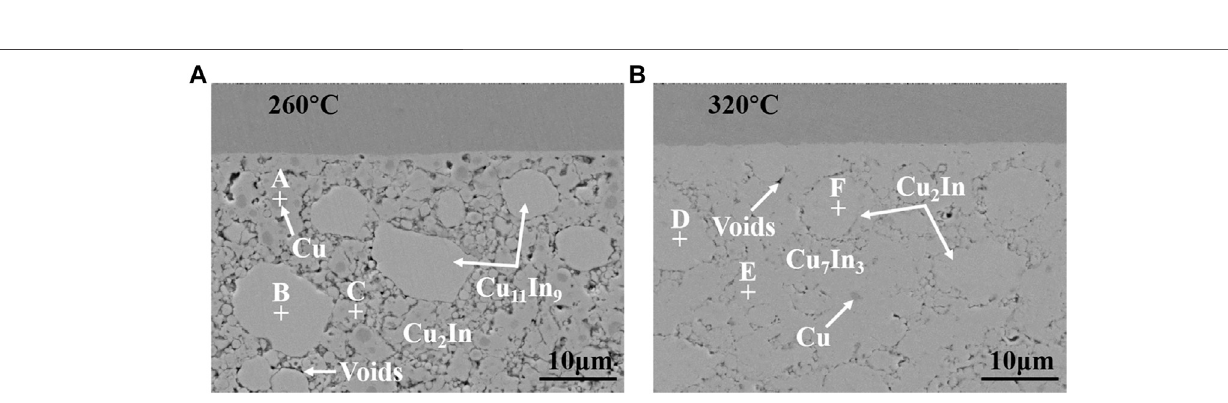
FIGURE 3 | The cross-sectional morphology of Cu-In TLPS joints after holding for 90 min under different bonding pressures: (A) 0.1 MPa, (B) 0.3 MPa, (C) 0.6 MPa, and (D) 1 MPa at 260 ° C, (E) 0.1 MPa, (F) 0.3 MPa, (G) 0.6 MPa, and (H) 1 MPa at 320 ° C.